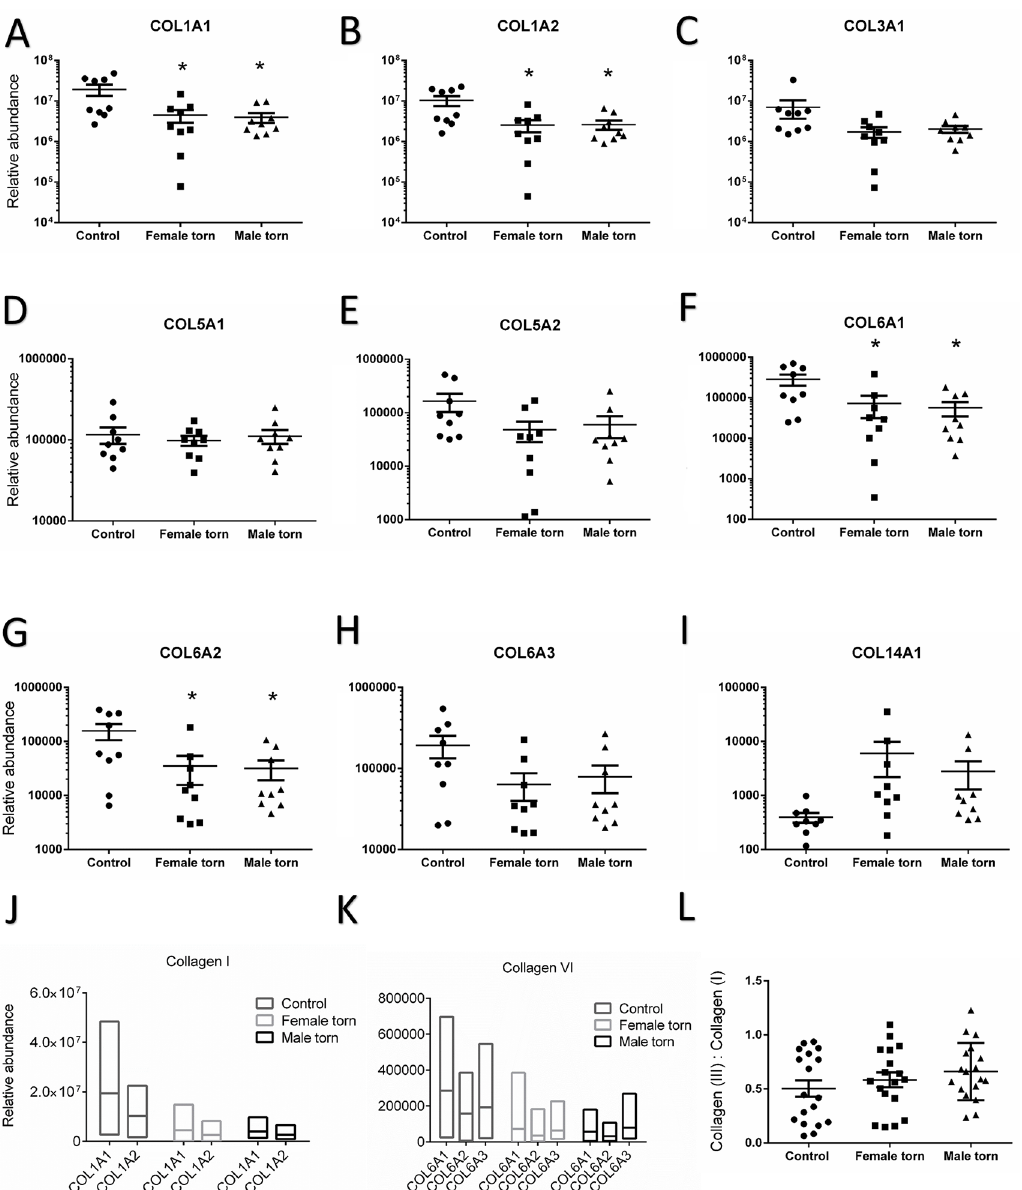
Fig 2. The relative abundance of collagens and their subunits in supraspinatus tendon from control and pathologic female and male donors. Dot plots show biologicalreplicates, means and standard error of the mean. (A) COL1A1, (B) COL1A2, (C) COL3A1, (D), COL5A1, (E) COL5A2, (F) COL6A1, (G) COL6A2, (H) COL6A3 and (I) COL14A1. (J) Floating bars showingminimum and maximum relative abundance of the subunitsof collagenI with a line at the mean and (K) the relative abundance of the subunitsof collagenVI. (L) The ratio of collagenIII to I, averageof ratios in individualruns within each group (duplicates per sample, n = 18 per group). * P < 0.05, ** P < 0.01significantly different from